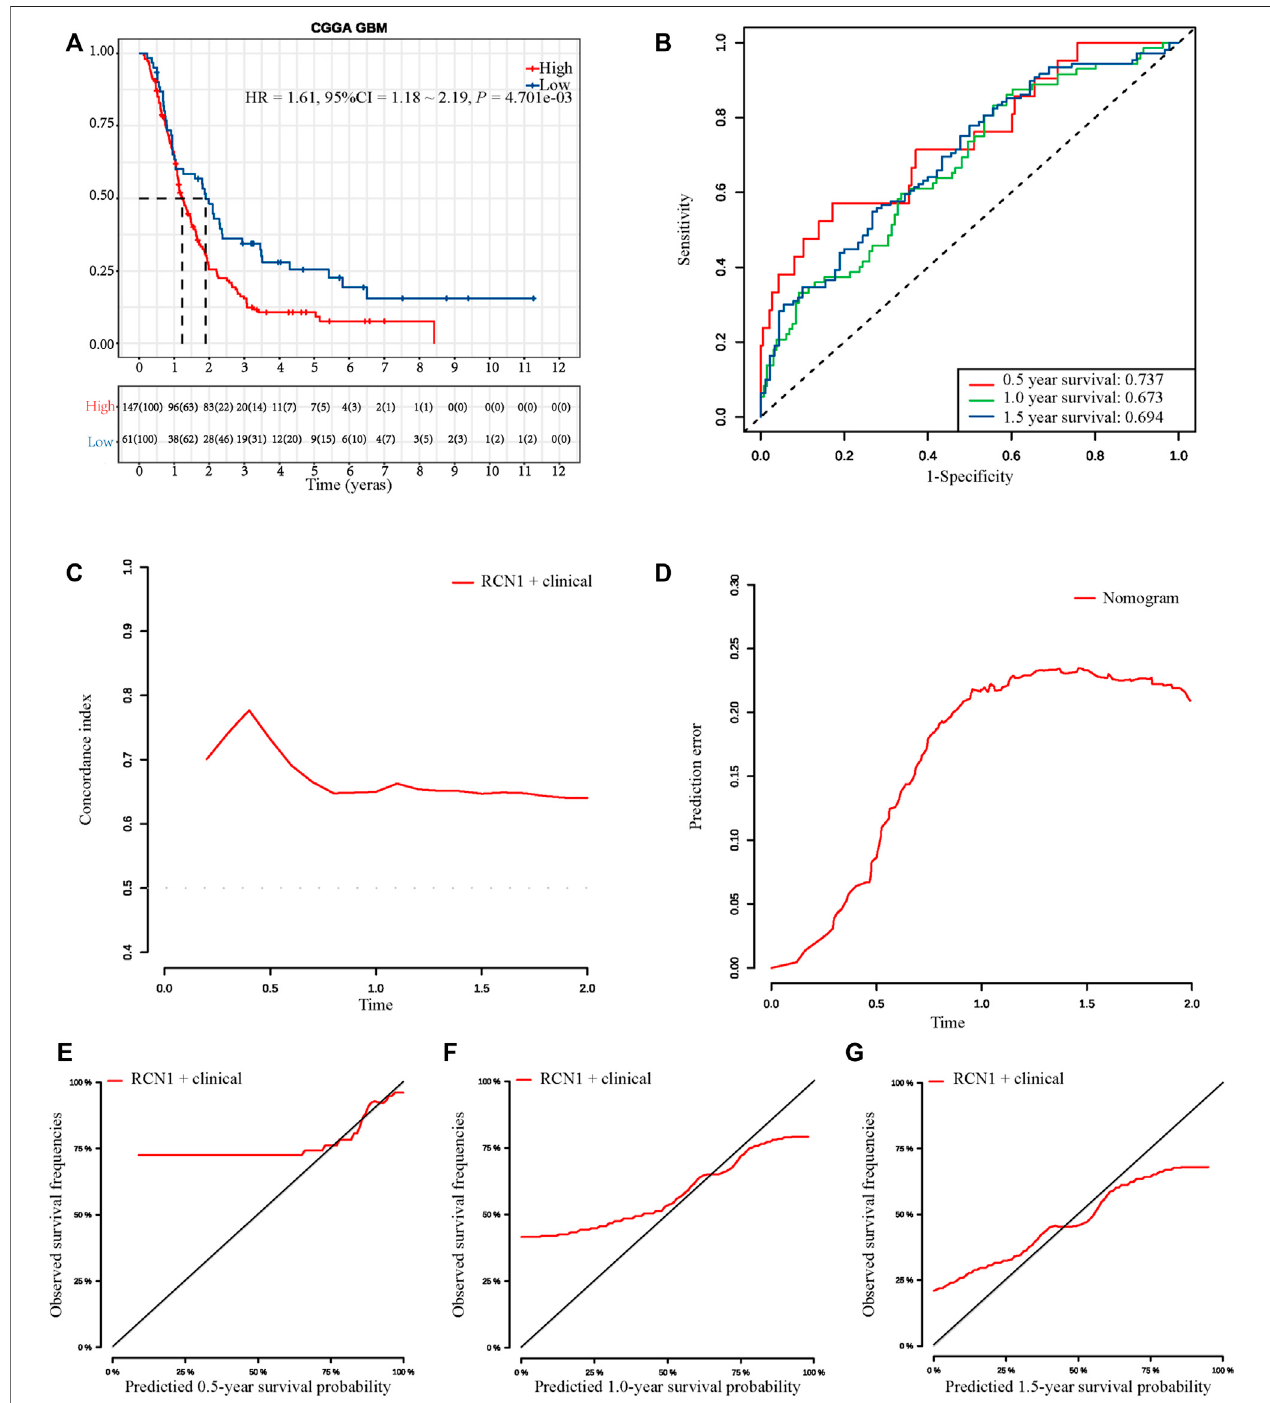
FIGURE 6 | External validation of the prognostic signature in CGGA. (A) Kaplan-Meier curve with log-rank test in CGGA. (B) ROC curves of the three models at different times. (C) C-index curves of the three models at different times. (D) Prediction error probability curves of the three models at different times. (E – G) Calibration curves of the three models at different